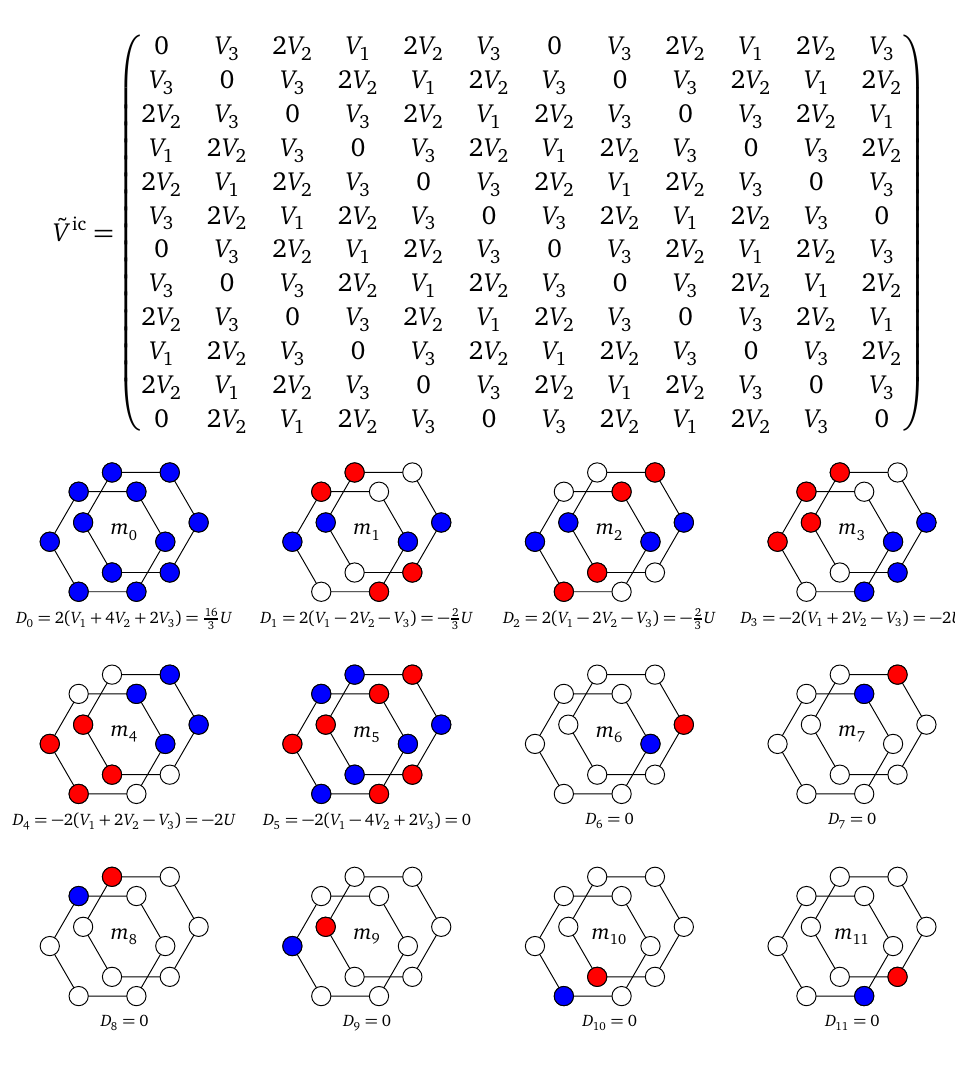
Table 2: Inter-cluster coupling matrix for the 12-site cluster used in this work. The numbering of sites is illustrated on Fig. 2. Bottom: eigenvalues D and corresponding µ eigenvectors (or eigen-operators) m of this matrix. The eigen-operators are shown µ graphically as a function of site on the 12-site cluster: blue means 1 and red 1. − The eigenvalues are also shown as a function of the on-site repulsion U when the constraints (5) are